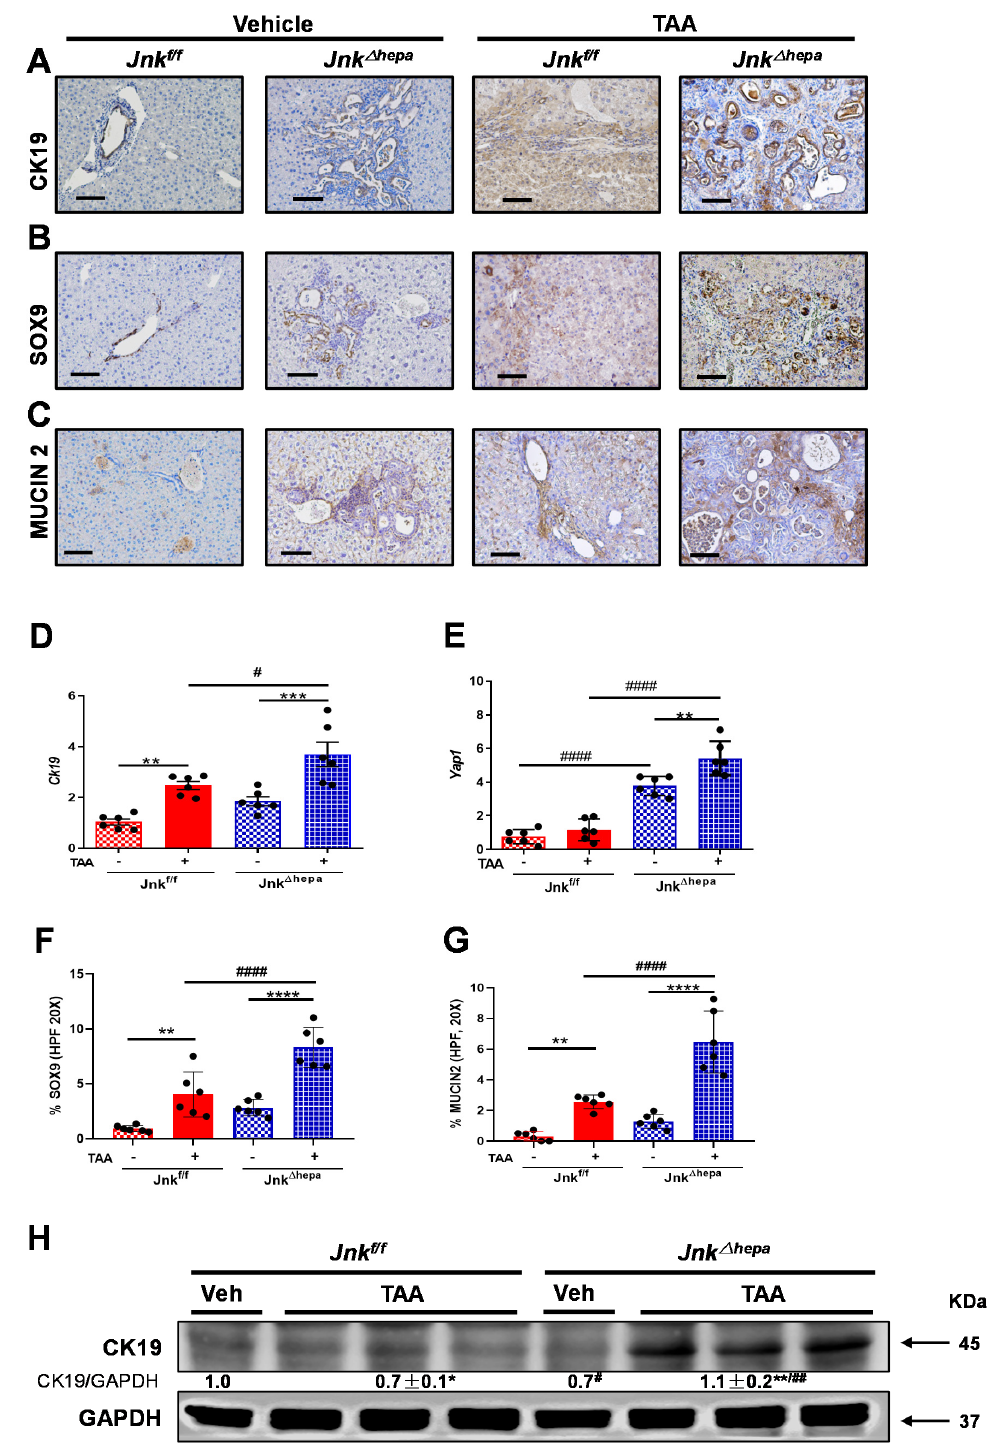
Figure 7. Markers of cholangiocarcinogenesis in Jnk ∆ hepa mice livers upon chronic TAA challenge. ( A – C ) Representative IHC staining for CK19, SOX9 and MUCIN2. Scale bars, 100 µ m. ( D , E ) mRNA expression of Yap1 and Ck19 , was evaluated by qRT-PCR. Quantification of Sox9 and Mucin2 positive cells/HPF (20X) was performed in the same livers. Percentage of SOX9 ( F ) and MUCIN2 ( G ) positive cells was performed in HPF (20X) in liver paraffin sections and graphed. ( H ) Expression of CK19 pro- tein was assessed via Western blot. Numbers denote the molecular weight (KDa) of proteins. GAPDH served as loading control. ( n = 6; */# p < 0.05; **/## p < 0.01; *** p < 0.001; ****/#### p <